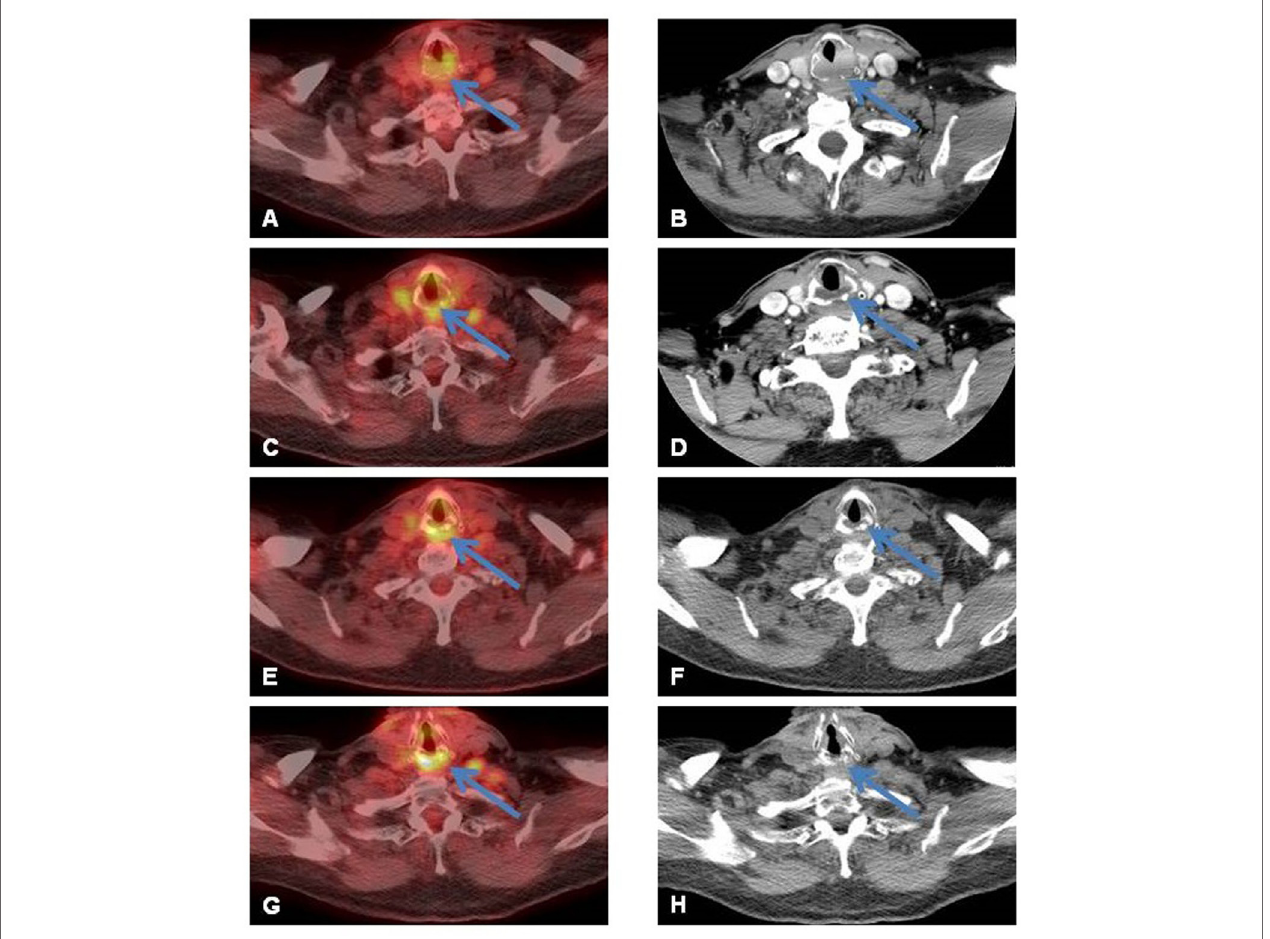
FIGURe 1 | (a) Focal increased FDG uptake [maximum standard uptake value (SUV) of 3.8] in the larynx noted on axial fused PET/CT image (blue arrow) corresponds to a (B) soft tissue mass (3.3 cm × 1.7 cm × 2.2 cm) in the posterior cricoid cartilage on contrast-enhanced (CE)-CT scan of the larynx (blue arrow). (C) Posttreatment follow-up FDG-PET/CT acquired 2 months after the end of the radiation therapy showed a decrease of the intensity of uptake; persistence of a very low diffuse uptake (SUV 4.9) is noted probably reflecting post-radiation changes (blue arrow). (D) CE-CT of the neck confirmed decreased size of the residual lesion, now measuring 2.5 cm × 1.0 cm × 2.0 cm (transverse by AP by craniocaudal) (blue arrow) and improved narrowing of the infraglottic airway. (e) Follow-up PET performed 6 months later showed persistent non-specific uptake (SUV 4.7) and (F) essentially unchanged size of the residual soft tissue on non-contrast, low-dose CT of the PET/CT. (G) One-year follow-up PET/CT demonstrated non-specific uptake, and (H) on corresponding non-contrast, low-dose CT of the PET/CT, normal appearance of the cricoid without residual soft tissue was